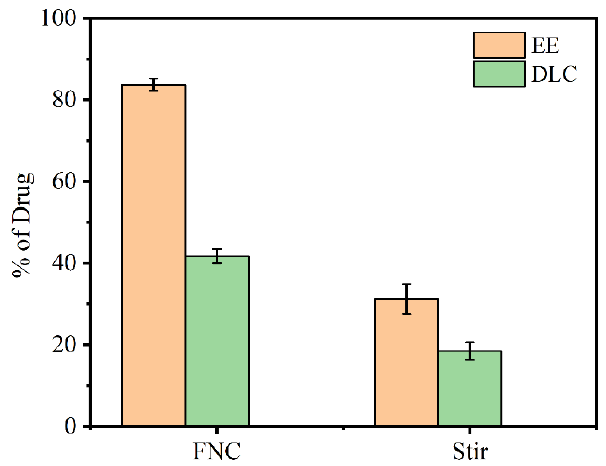
Figure 5. Encapsulation efficiency and drug loading capacity of Cur-loaded CS nanocomplex pre- pared by FNC and conventional bulk methods.